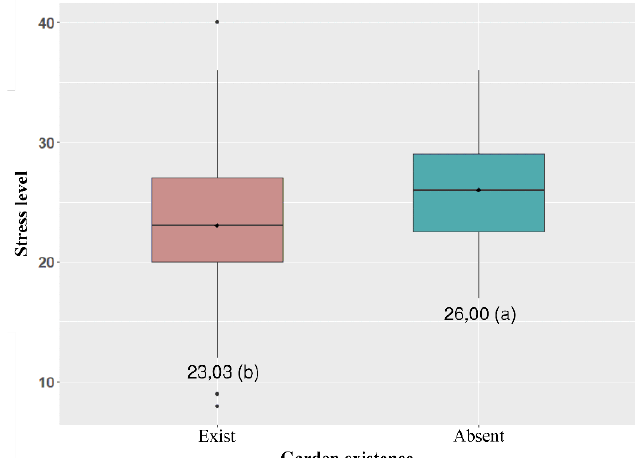
Figure 7. Box plot of garden existence factor with mental well-being level (left) and stress level